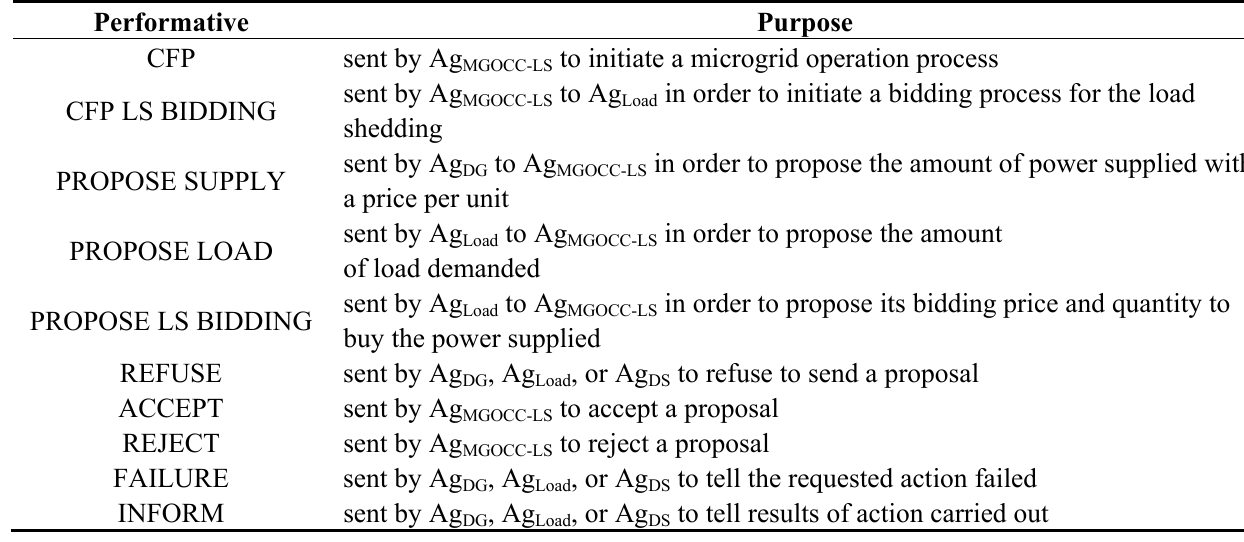
Table 1. Extended FIPA-CNP performatives for load